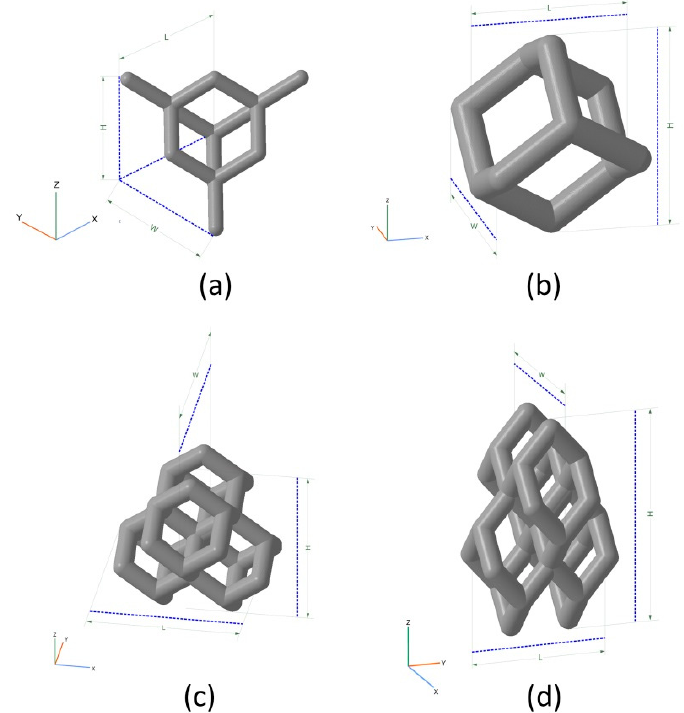
Figure 4. Unit cells used for implant modeling: ( a ) UC001—the unit cell built on the basis of tetrahedral diamond structure (rib thickness = 0.4 mm, cell length (L) = 2.3 mm, cell width (W) = 2.3 mm, cell height (H) = 1.7 mm); ( b ) UC00202—the cell built on the basis of the UC001 unit cell by removing open ribs (rib thickness = 0.7 mm, L = 1.6 mm, W = 1.6 mm, H = 2.3 mm); ( c ) UC003—the cell built by replicating the UC002 unit cell along the X and Y axes by a factor of 2, with the offset along Z-axis by H/2, and along X-axis by W/2 (rib thickness of 0.7 mm, L = 3.5 mm, W = 3.5 mm, H = 3.8 mm); ( d ) UC004—the cell built by compressing the UC003 unit cell along X and Y axes by the factor of 2 (rib thickness = 0.3 mm, L = 2.0 mm, W = 2.0 mm, H = 4.1 mm).